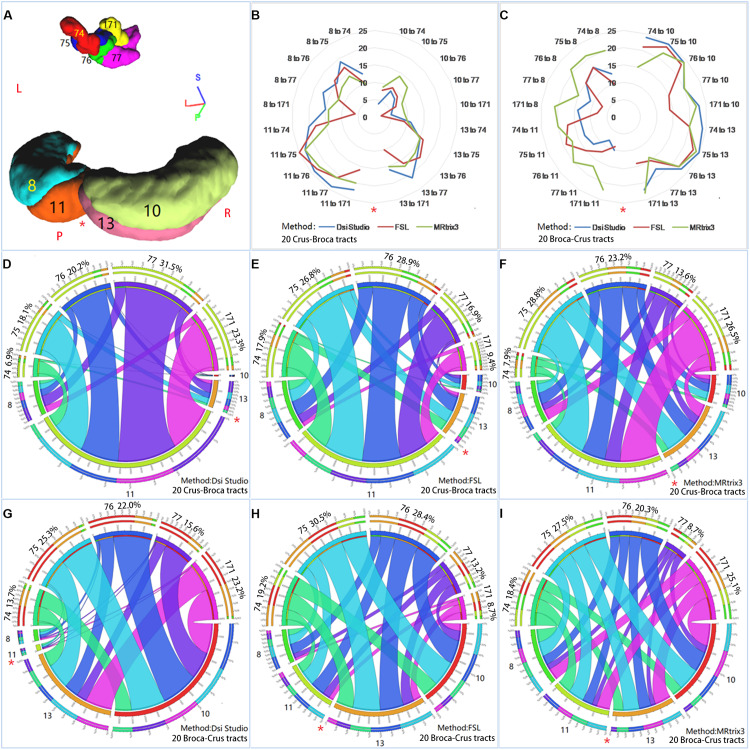
Reciprocal structural network interactions between bilateral Crus lobes and Broca’s complex. (A) Bilateral Crus lobes [four Crus regions of interest (ROIs)] and five ROIs of Broca’s complex (five Broca ROIs) used to reconstruct reciprocal structural network interactions. (B,C) The numbers of subjects among the 26 subjects for which each of 20 Crus–Broca tracts (B) or each of 20 Broca–Crus tracts (C) are reconstructed via each tractography method. As the tool of “Circos” show, reciprocal structural network interactions between these Crus ROIs and Broca ROIs through Crus–Broca tracts (D–F) and Broca–Crus tracts (G–I) exist by adding the structural connectivity strength values of each Crus–Broca tract and Broca–Crus tract from all subjects together within the same category of tract as reconstructed by one method among DSI Studio (D,G), FSL (E,H), and MRtrix3 (F,I). The asterisk in each panel indicates the midline separating the left Crus ROIs from the right Crus ROIs. Each number following the name of Broca ROI (for example, “74”) in each panel is the percentage of the ROI’s contribution as target points in Crus–Broca tracts (D–F) and also as origin points in Broca–Crus tracts (G–I).